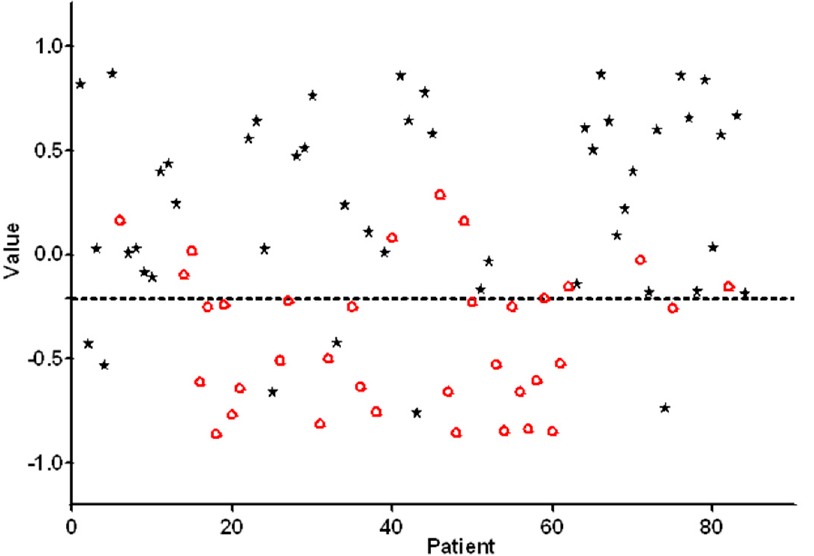
Figure 2. Individual e-nose values for each patient and control of the training set are plotted. Values > − 0.21 are scored as being positive for oral squamous cell carcinoma (OSCC). The black asterisks represent patients with histopathologically confirmed OSCC. The red circles represent healthy controls.